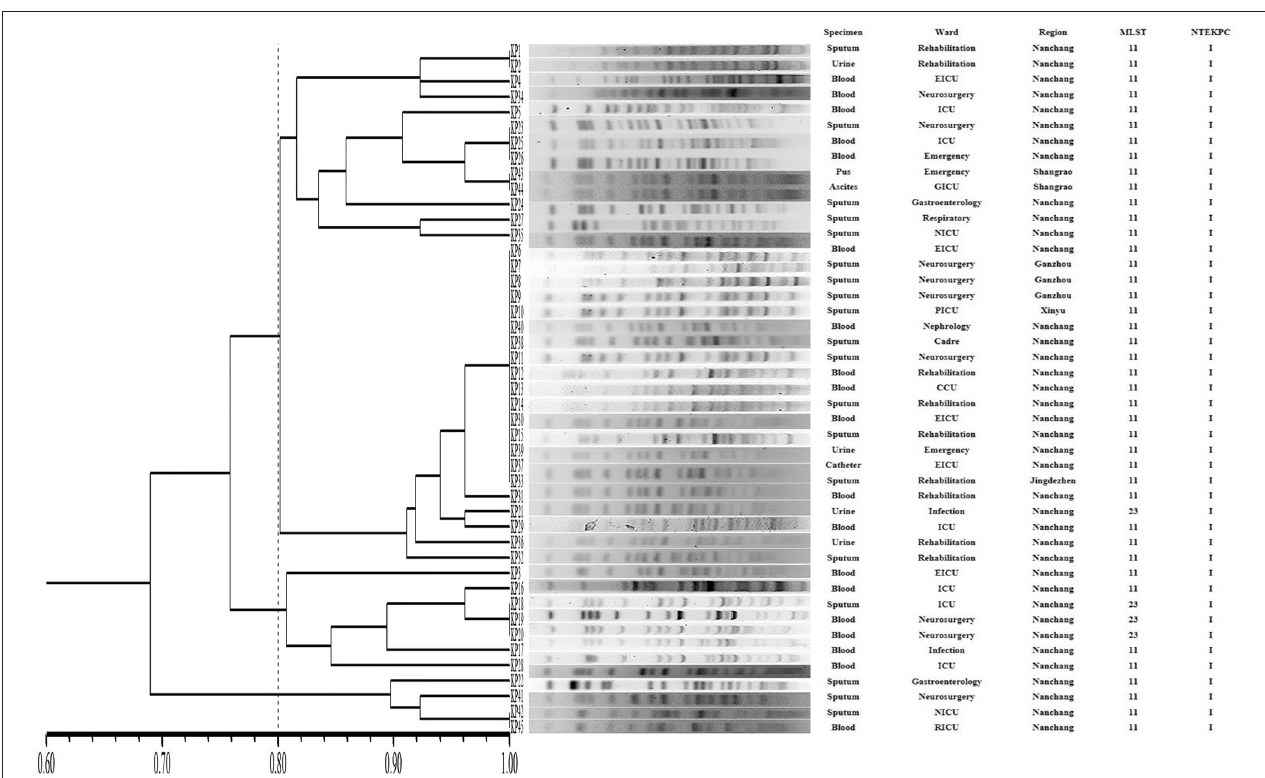
FIGURE 3 | Pulsed-field gel electrophoresis (PFGE) patterns, NTE KPC patterns, and STs among 45 clinical CR-hvKP isolates. NICU, neurosurgery ICU; GICU, gastroenterology ICU; RICU, respiratory ICU; PICU, Pediatric ICU; EICU, Emergency